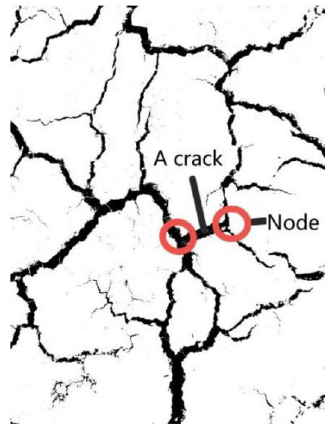
Figure 9. Crack number image.